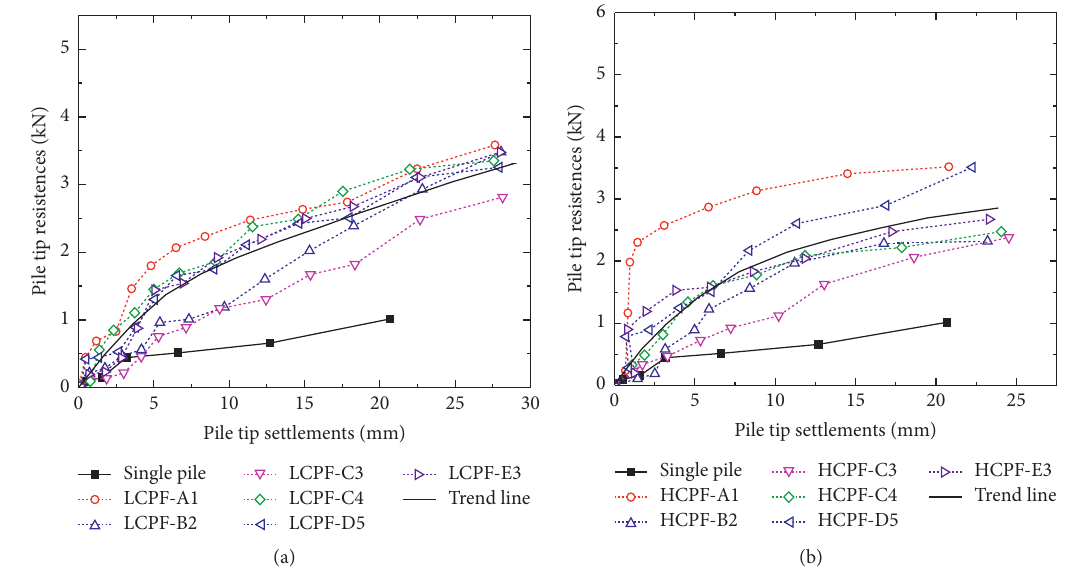
Figure 12: Pile tip resistance versus the pile tip settlement. (a) LCPF piles and single pile. (b) HCPF piles and single